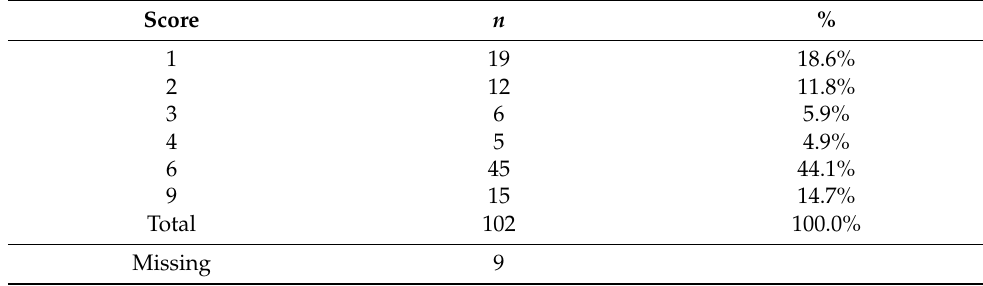
Table 2. EGFR expression: results of the composite scores (N = 111).